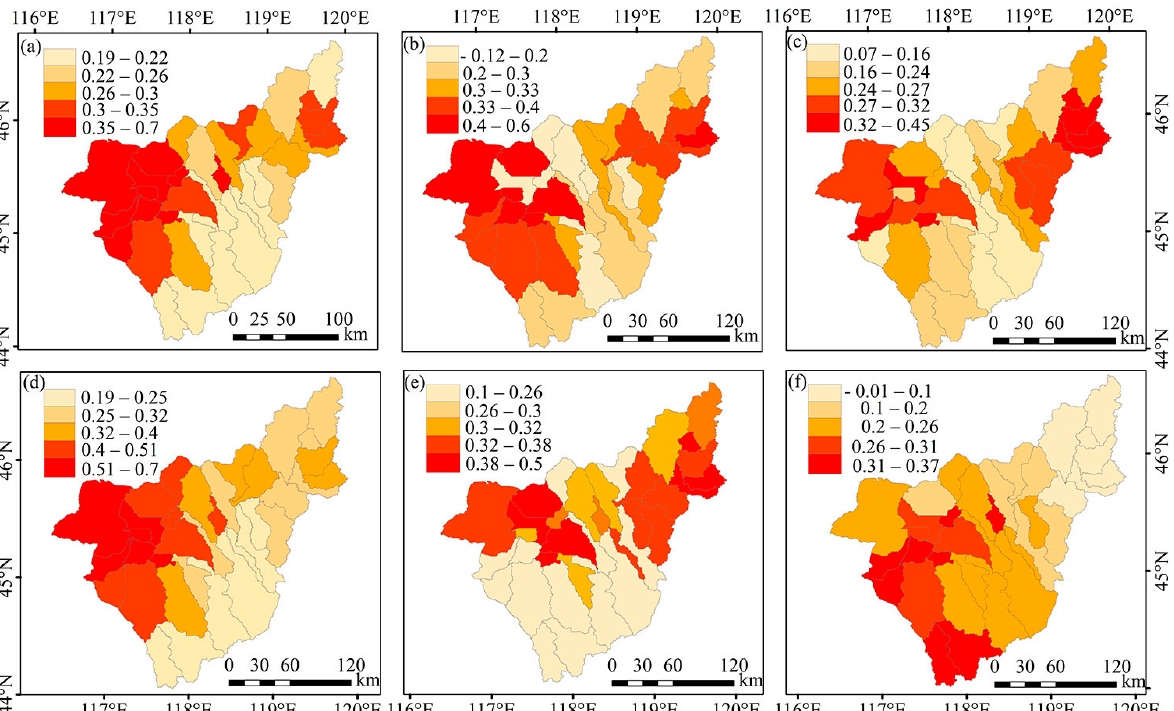
Figure 9. Synergy relationships between the URB’s hydrological process factors and EQ: ( a ) precipitation, ( b ) ET, ( c ) runoff depth, ( d ) lateral flow, ( e ) groundwater recharge, and ( f ) snowmelt.